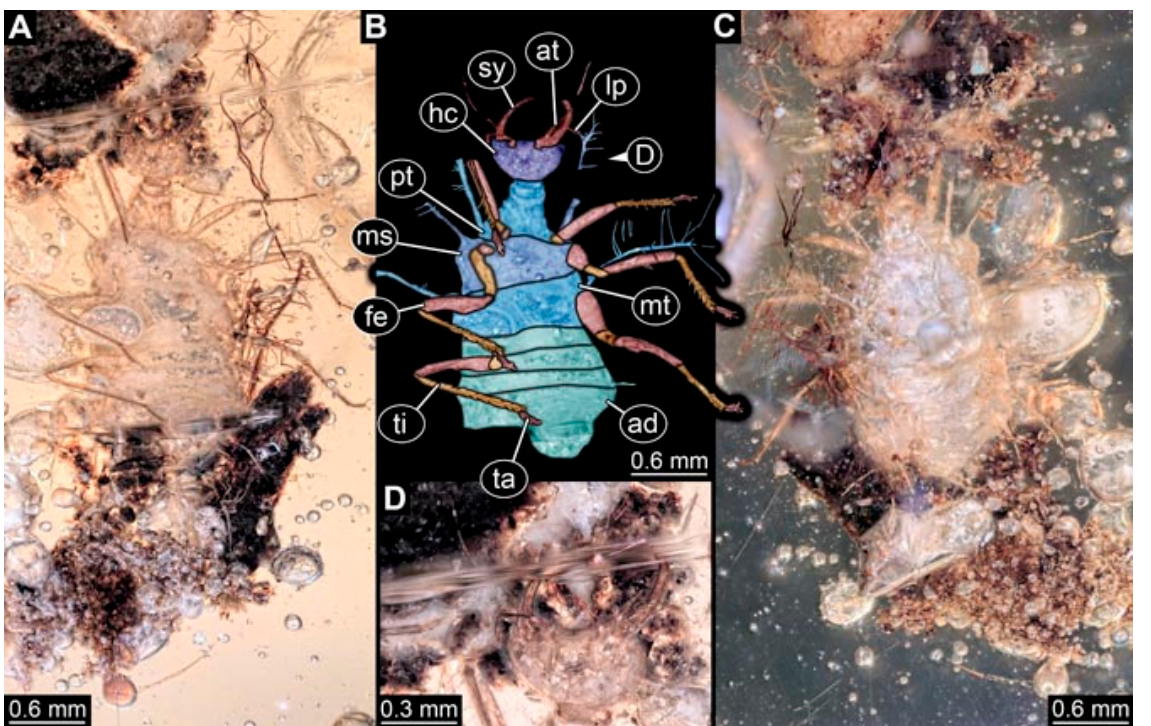
Figure 6. Specimen 4820 (BUB 3361); Myanmar amber. ( A ) Ventral view. ( B ) Ventral view, colour- marked. ( C ) Dorsal view. ( D ) Close-up of head capsule in ventral view. Abbreviations: ad = abdomen; at = antenna; fe = femur; hc = head capsule; lp = labial palp; ms = mesothorax; mt = metathorax; pt = prothorax; sy = stylet; ta = tarsus; ti = tibia.